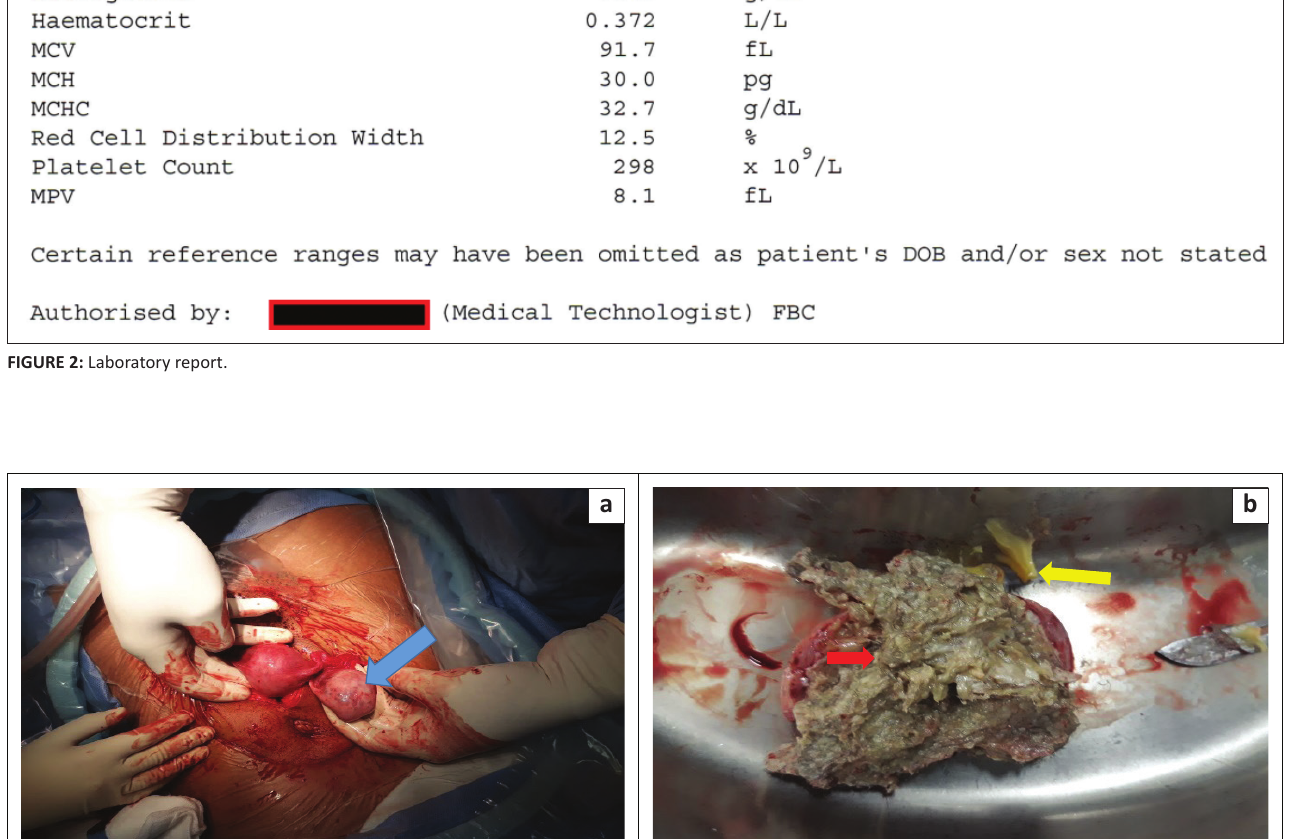
FIGURE 3: (a) An enlarged right ovary (blue arrow); (b) cut section through the excised ovary. Note the presence of sebum material (yellow arrow) and hair (red arrow).